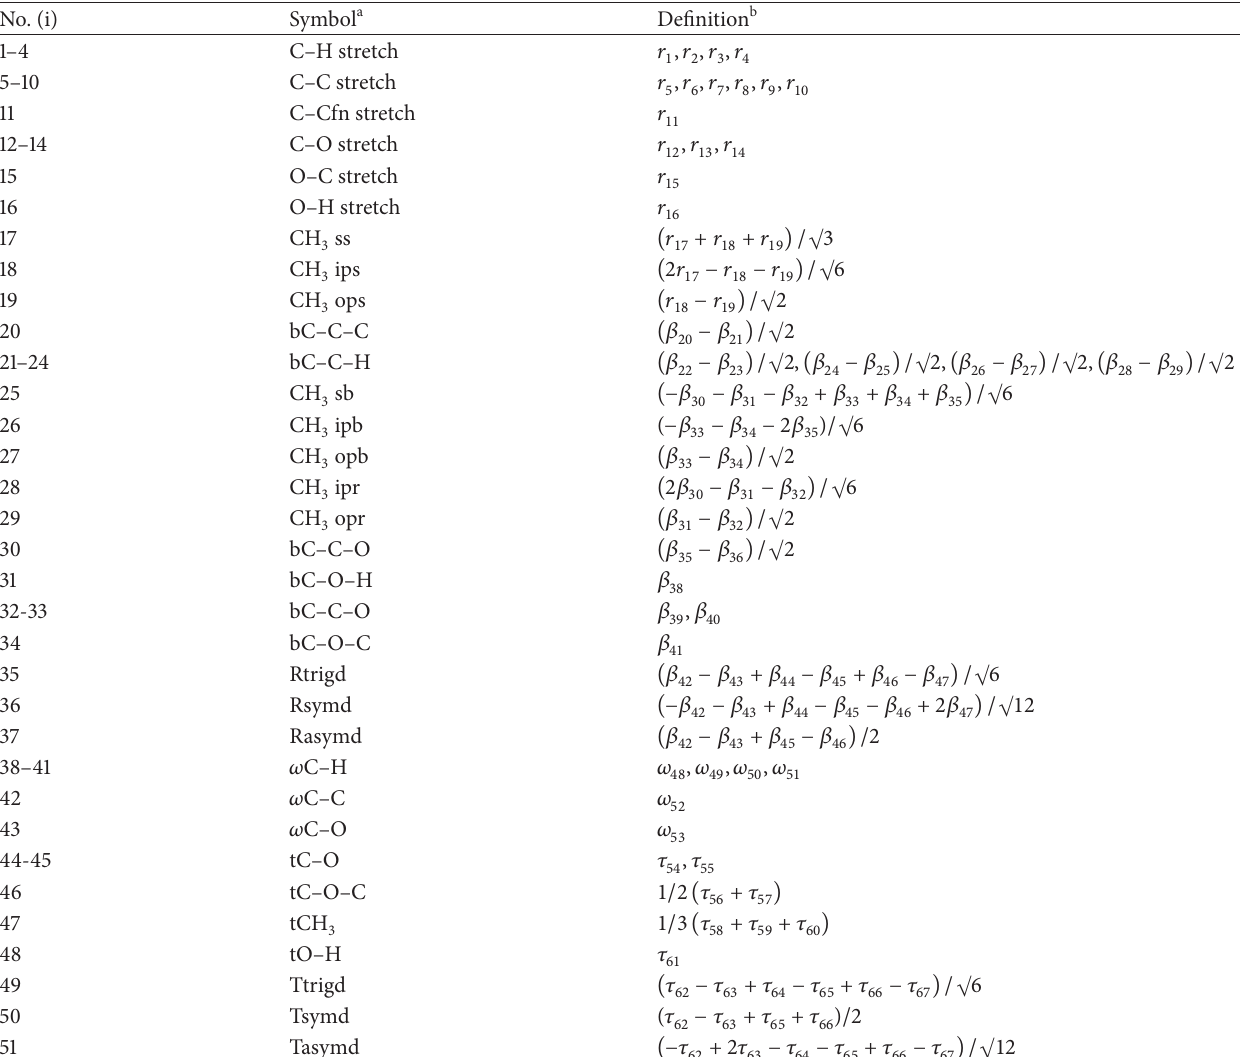
Table 5: Definition of natural internal coordinates of Anisic acid